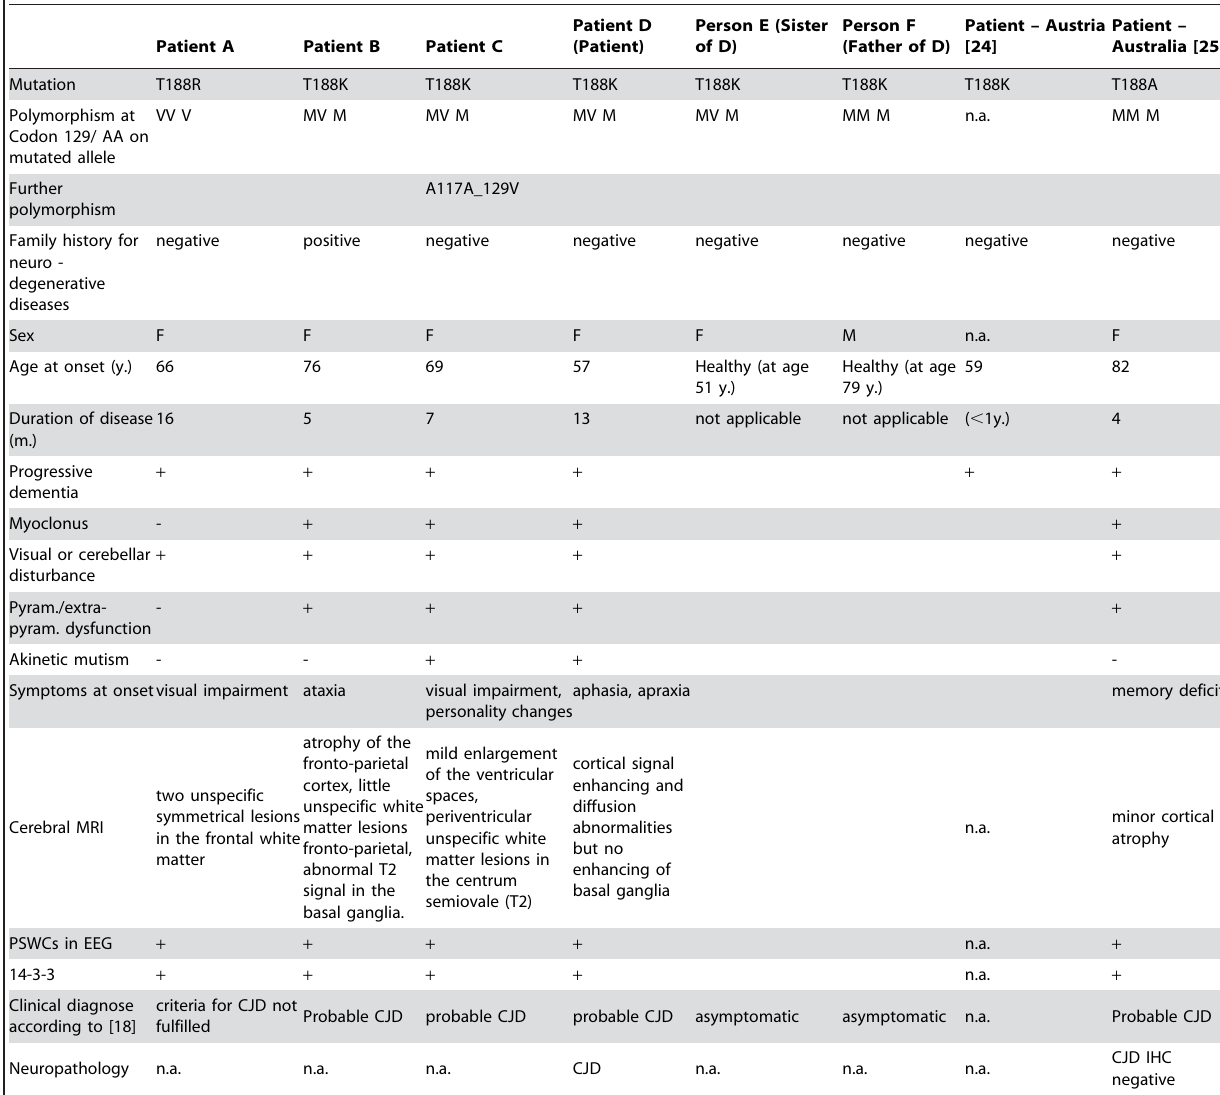
Table 1. Features of the prion diseases associated with mutations at codon 188. Abbreviations: AA =amino acid; n.a.=not available, IHC=Immunohistochemistry; m.=month; M =methionine; V=valine; y.